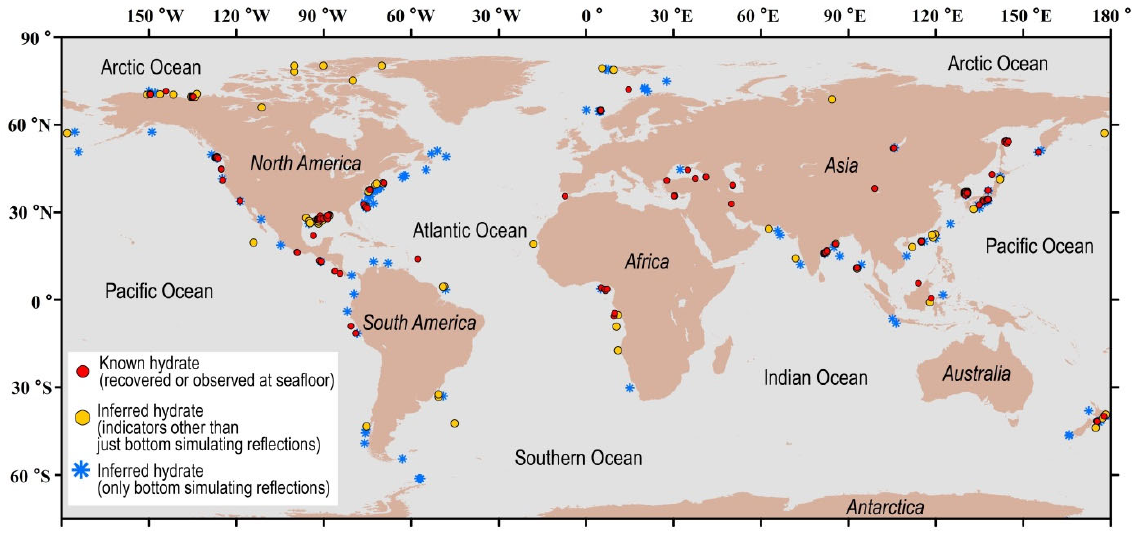
Figure 1. Global map of recovered and inferred gas hydrates (from the Woods Hole Coastal and Marine Science Center, 2020).